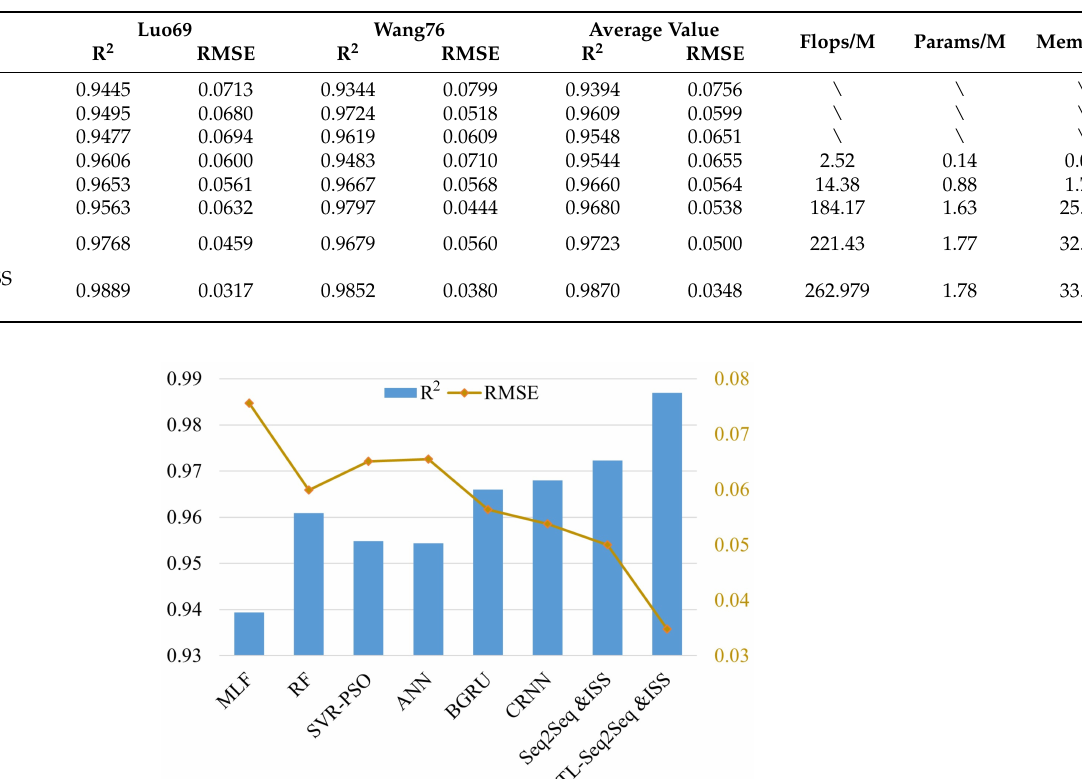
Table 6. The comparison between the proposed methods and the advanced algorithms.